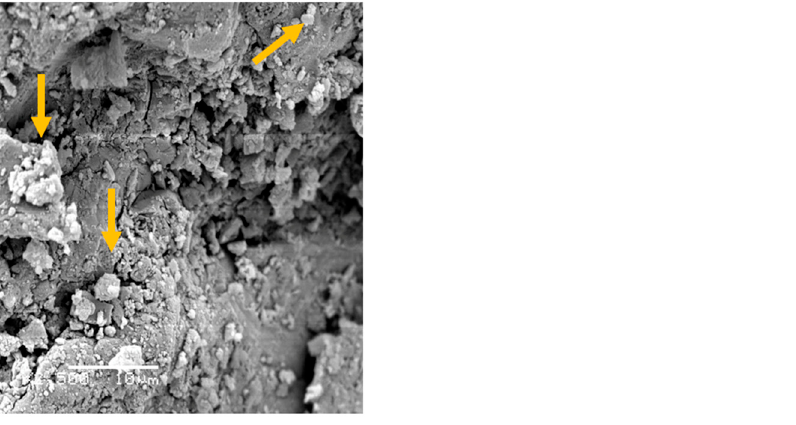
Table 1. AB and ALP data in days 1 and 14.